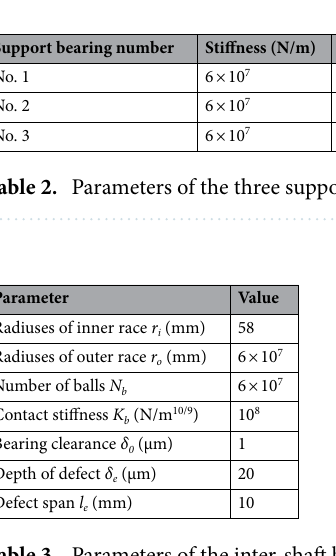
Table 3. Parameters of the inter-shaft